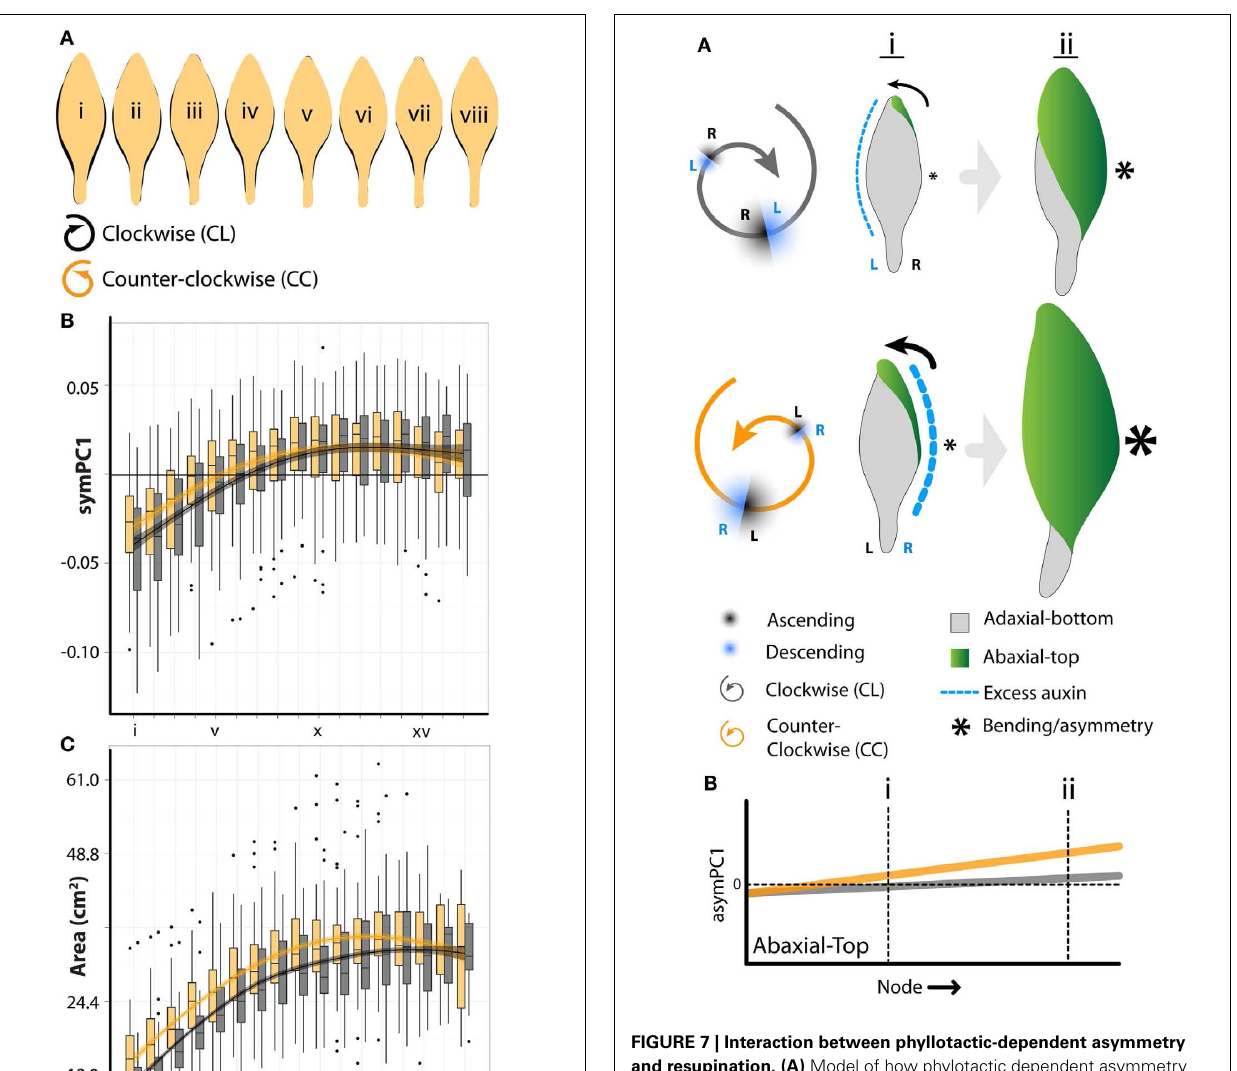
FIGURE 7 | Interaction between phyllotactic-dependent asymmetry and resupination. (A) Model of how phylotactic dependent asymmetry either facilitates or hinders resupination. In clockwise phyllotaxis (black) the descending side of the leaf (toward the older neighbor) is the left side. Auxin is biased toward the left side of the leaf (dotted blue line) where it presumably creates excess blade outgrowth and a distal shifting of features. Resupination, however, begins on the right side of the leaf with the folding over of blade (arrow). In counter-clockwise phyllotaxis (CC, orange), the auxin bias (blue dotted line), the excess blade outgrowth it creates, and resupination (arrow) all occur together on the right side of the leaf. Presumably the excess blade outgrowth generated by the auxin bias facilities resupination. As resupination is intimately tied to the development of leaves, this allows CC to progress through their developmental program faster, generating larger leaves at early (i) and later (ii) nodes relative to CL leaves. Additionally, the arcing of leaves away from the left (asterisk size) induced by resupination proceeds to a more extreme state in CC phyllotaxis. (B) Diagrammatic representation of the data shown in Figure 5 for abaxial-top images.The positive slope of asymPC1 values in leaves as one progresses away from the apex indicates an intrinsic asymmetry in these leaves. CC leaves are more asymmetric than CL leaves. However, in light of the eventual convergence in shape ( Figure 6B ) and area ( Figure 6C ) between CL and CC leaves suggestive of developmental delay, CL leaves likely eventually attain CC asymmetric values, albeit at nodes farther from the apex.This interpretation suggests that intrinsic asymmetry results from the developmental progression of leaves and the resupination